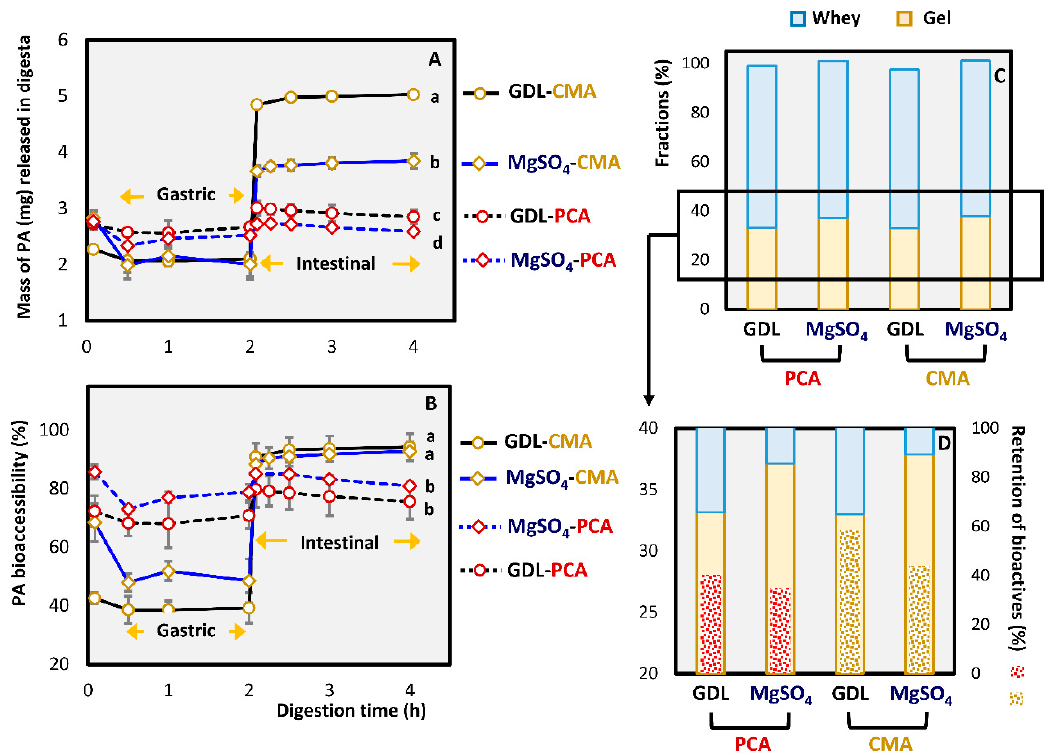
Figure 6. Release of added phenolic acids (PA); CMA and PCA from GDL- and MgSO 4 -induced pressed gels during in vitro digestion. Mass of bioactives released (mg) ( A ) and release percentage normalized with the mass of bioactives that remained in the gel after pressing ( B ). Fraction (%) of gel and whey serum after pressing ( C ) and magnification of image C with the differences in the retention (%) of phenolic acids in the gel after pressing ( D ). The values were represented as means ± standard deviations ( n ≥ 3). Different letters indicate significant differences ( p ≤ 0.05).